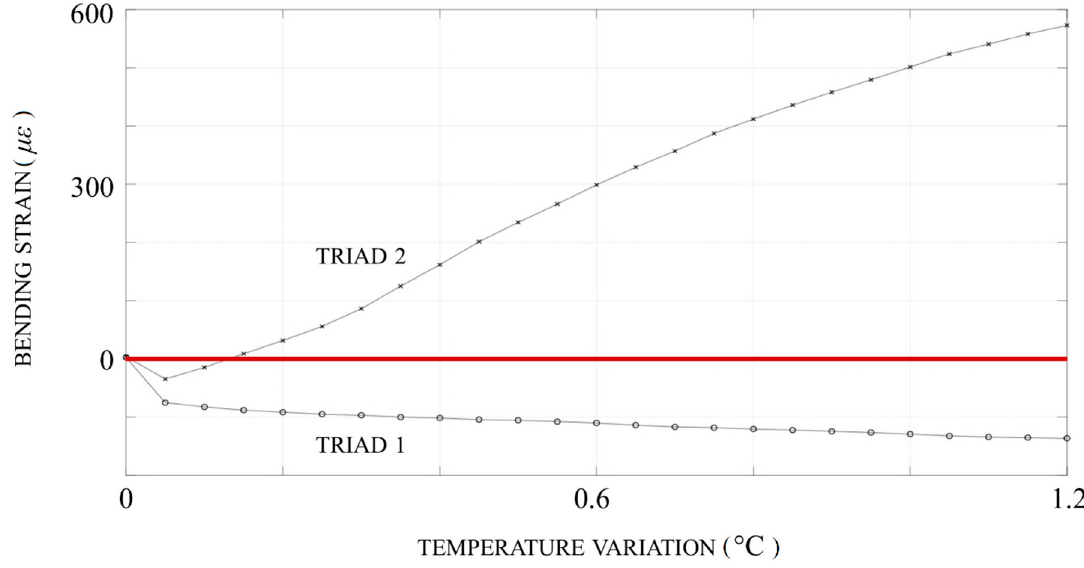
Figure 7. Bending strain vs. temperature rise: a prominent downward concavity (evidenced by a surge in bending strain) around the defect developed concomitantly with a much more modest upward concavity (negative) at the inlet.